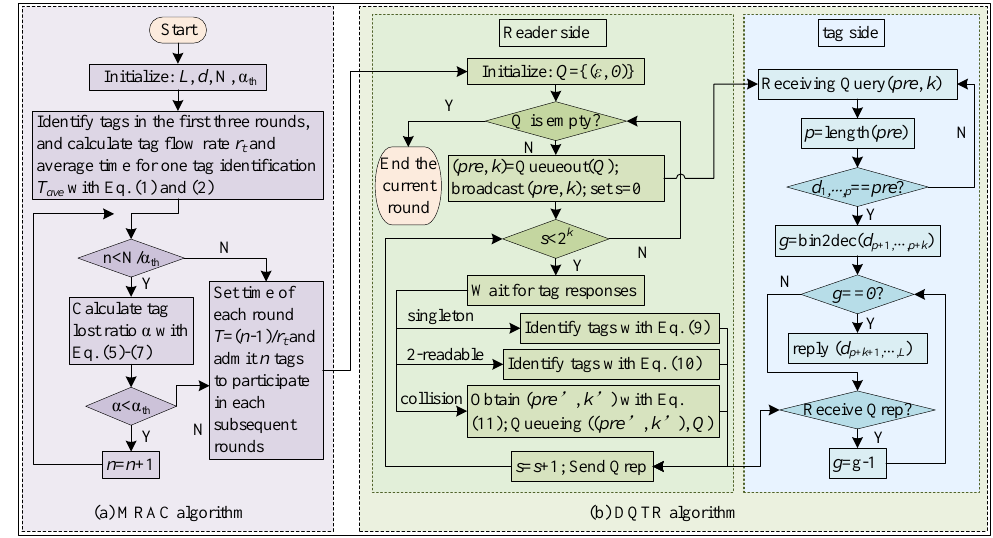
Figure 6. Flowchart of the proposed ACDQT algorithm: ( a ) the admission control phase with MRAC; ( b ) the identification phase in each round with DQTR.